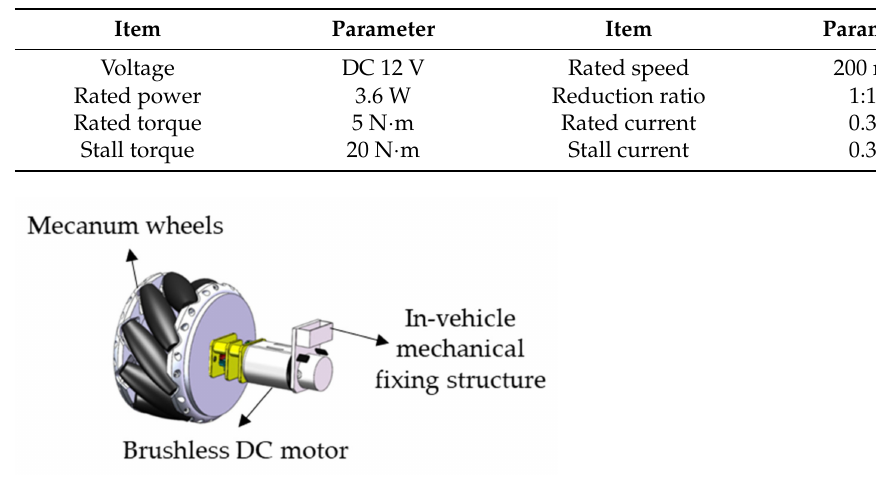
Table 1. Parameters of a DC motor.